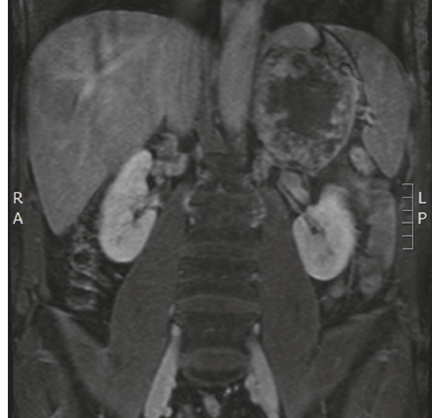
Figure 2: Gadolinium-enhanced T1 abdominal MRI, coronal view, showing a large heterogeneous left adrenal mass.